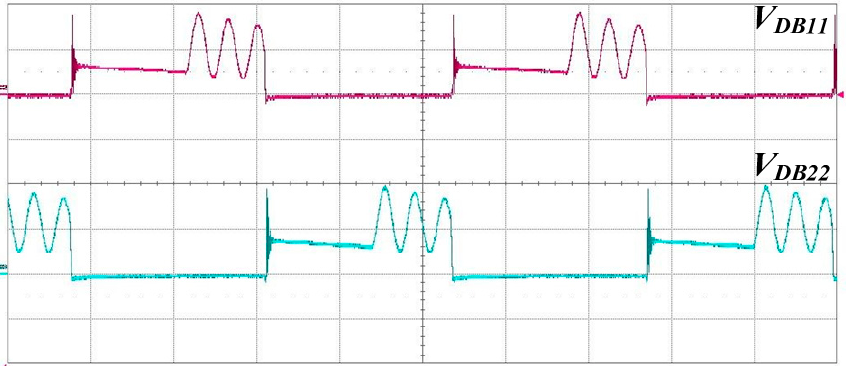
Figure 13. Measured voltages on the diodes D B 11 and D B 22 . Voltage scale: 200 V/div; time scale: 5 μ s/div.